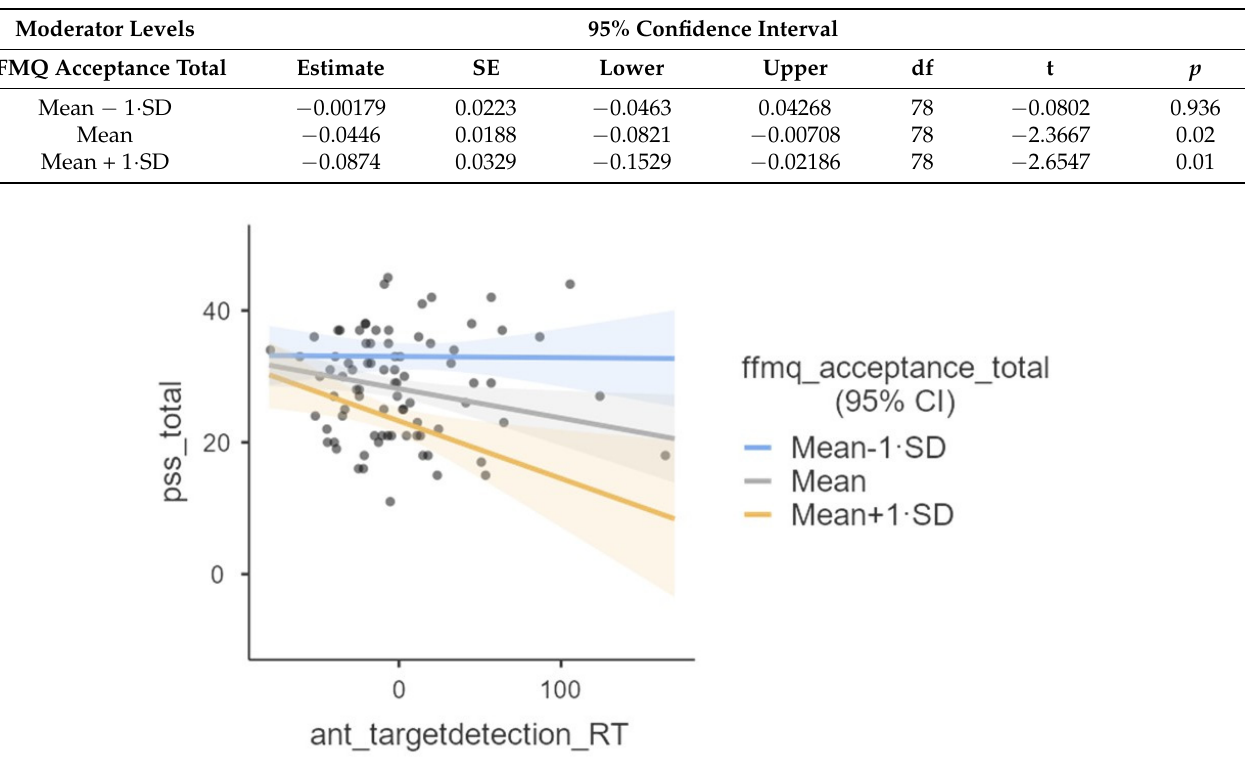
Table 7. Simple slopes analyses showing changes in the association between Chronic Stress (i.e., PSS scores) and Target detection (i.e., target detection coefficient) as a function of Acceptance (i.e., combination of the FFMQ acceptance subscales scores).